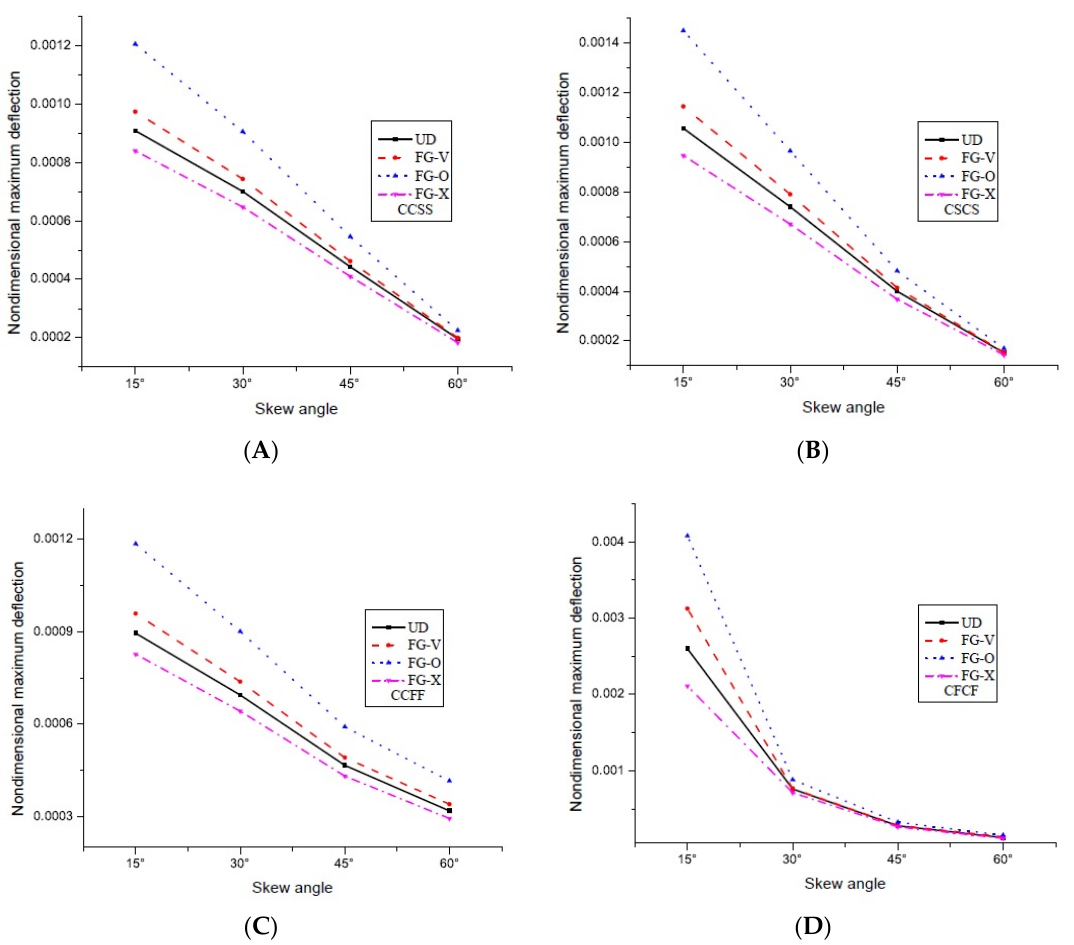
Figure 7. Variation of non ‐ dimensional deflection of FG ‐ CNT ‐ reinforced rhombic plate with the skew angle subjected to sin ‐ sin loading for ( A ) CCSS, ( B ) CSCS, ( C ) CCFF and ( D ) CFCF boundary condition.